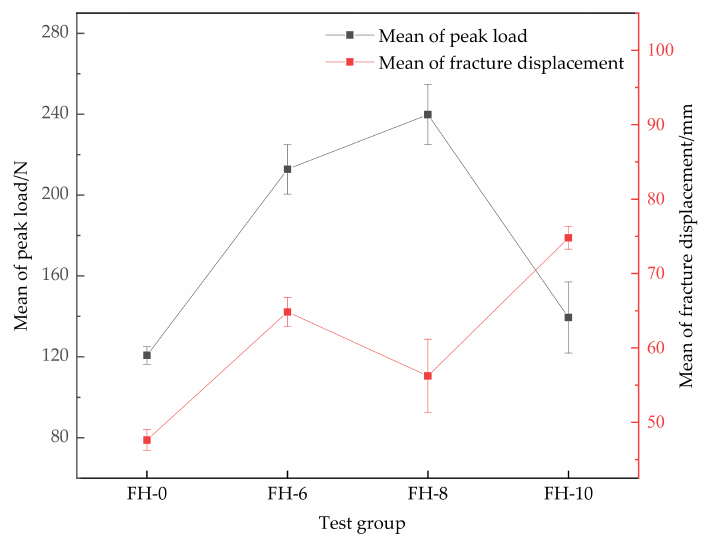
Figure 7. Average peak load, average fracture displacement and standard deviation in GFRP/foam sandwich composites using CSB